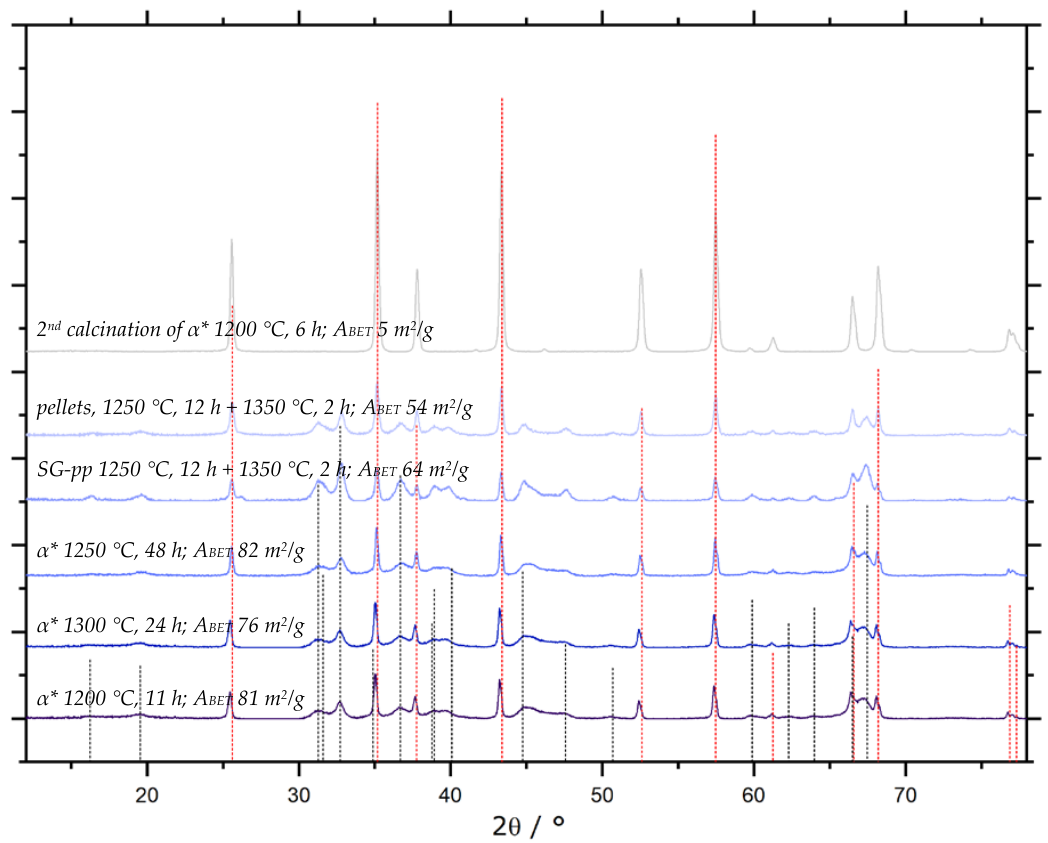
Figure 17. XRD patterns of pore-protected θ -alumina samples with indicated calcination conditions and A BET determined from N 2 sorption measurements. The three bottom patterns arise from α -doped sol-gel alumina ( α *). Red dotted lines indicate α -Al 2 O 3 reflexes, black dotted lines indicate θ -Al 2 O 3 reflexes.